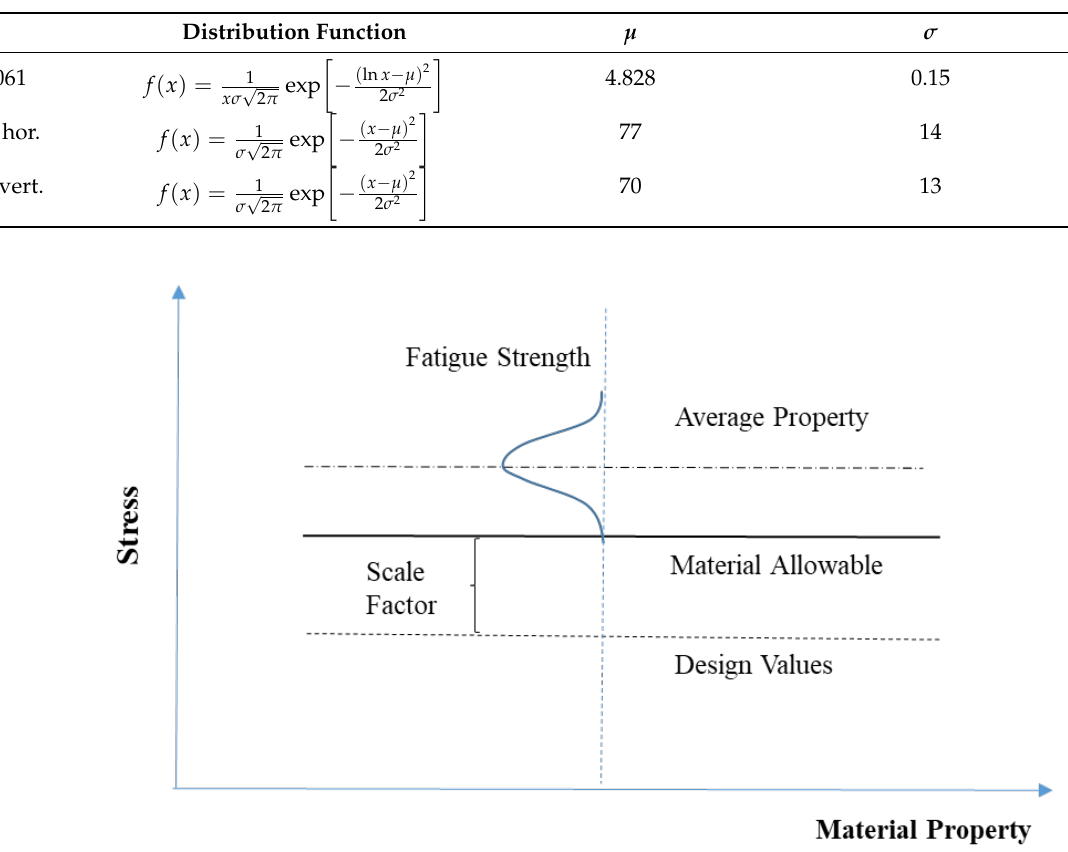
Figure 8. Approach to design allowable determination, after [4].